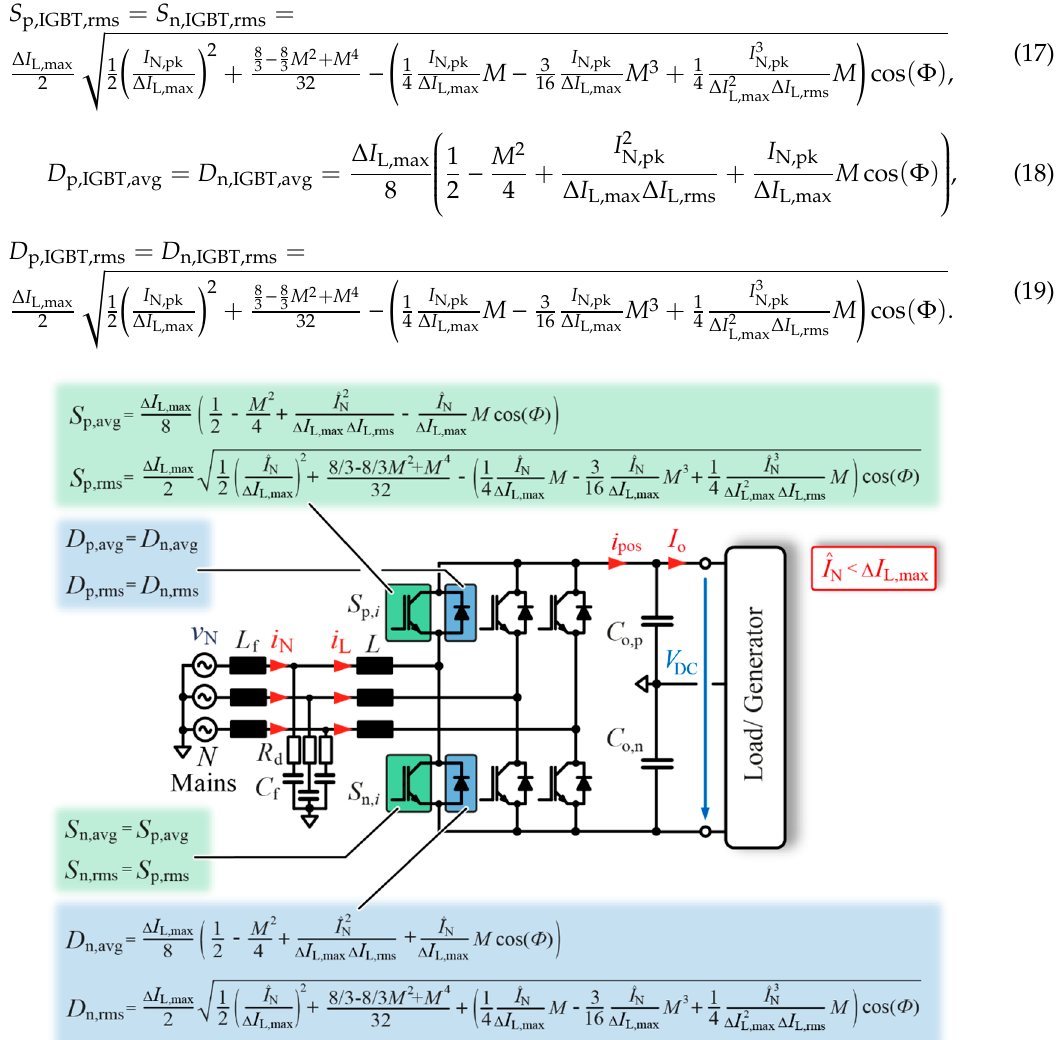
Figure 8. Current stress of an IGBT-based three-phase six-switch inverter topology, incorporating the existing current ripple, for light- and no-load operation ( I N,pk < ∆ I Lmax ).